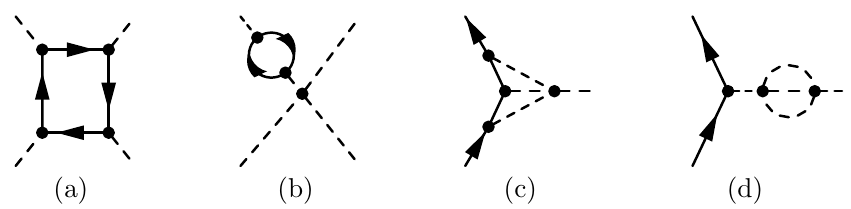
Figure 1 . Diagrams that couple the scalar and Yukawa RGE sectors. The quartic couplings get Yukawa contributions in their beta functions from diagrams of the type in (a) and (b) already at 1-loop order. The quartics enter the Yukawa beta functions (cid:12)rst at 2-loop order through diagrams like the ones in (c) and